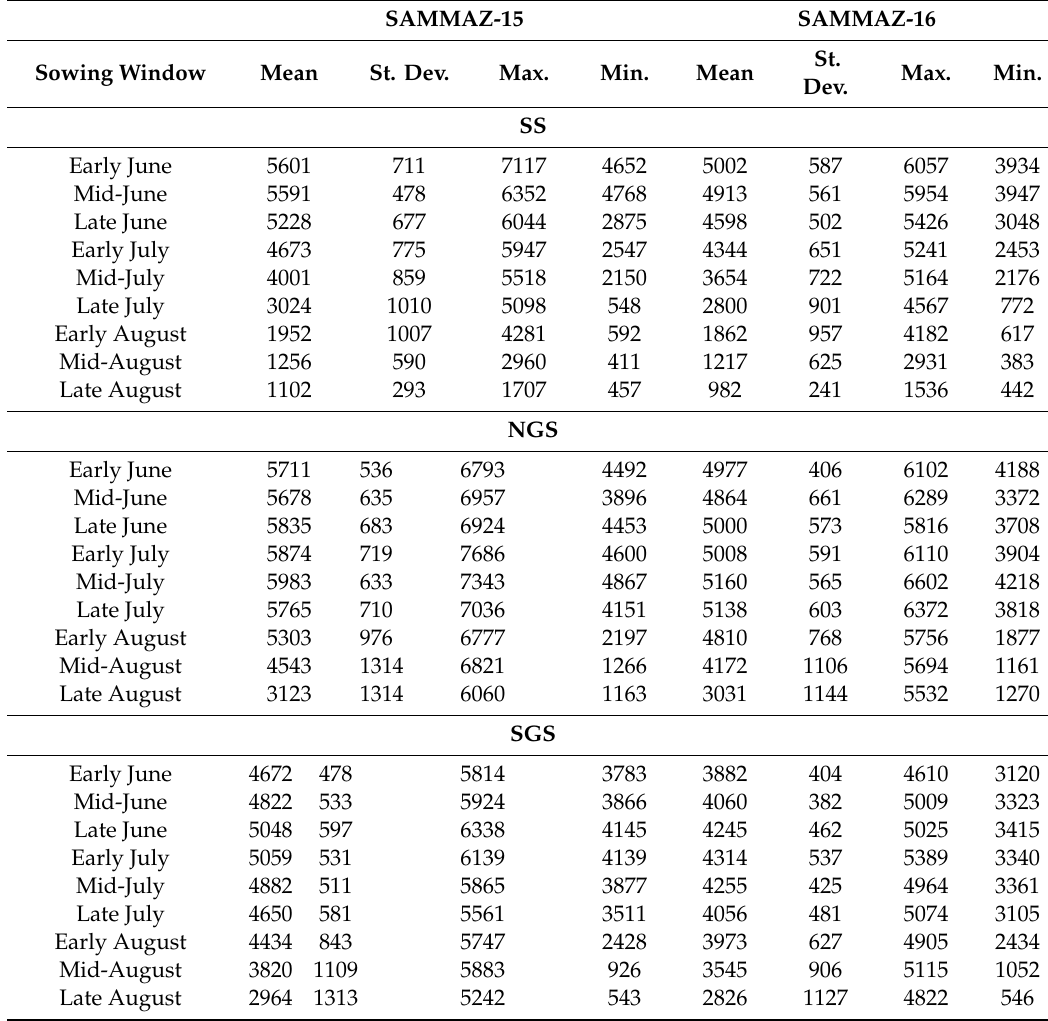
Table 4. Grain yield (kg ha − 1 ) of 30-year (1985–2014) seasonal analysis (model application) for SAMMAZ-15 and SAMMAZ-16 using di ff erent sowing windows at SS, SGS, and SGS in Nigeria. SAMMAZ-15 St. Max. Sowing Window Mean St. Dev. Max. Min. Mean Dev.